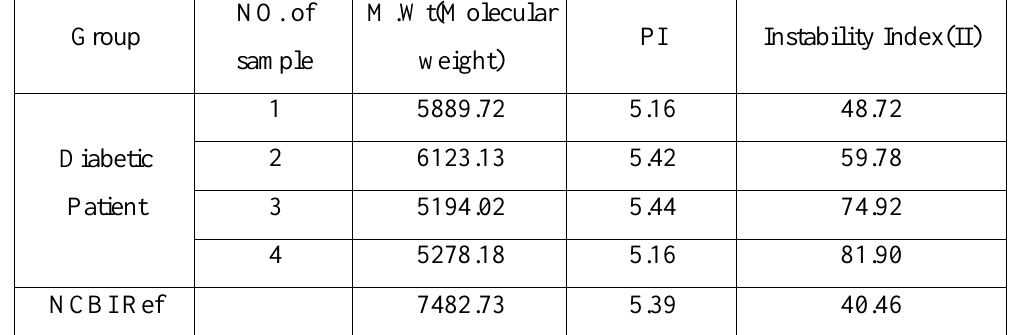
Table 5: The physiochemical properties of TCF7L2 protein in diabetic patients and the standard from NCBI.